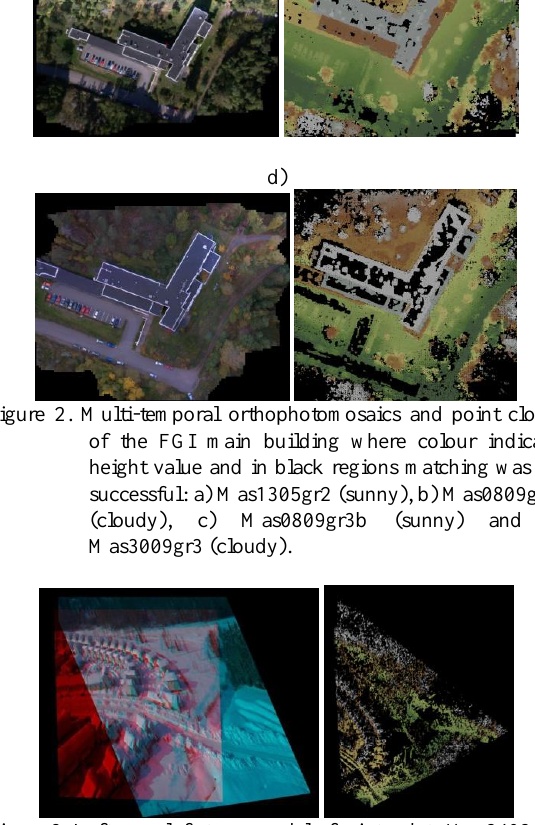
Figure 3. Left: anaglyf stereo model of winter data Mas2402gr3. Right: Point cloud by NGATE.